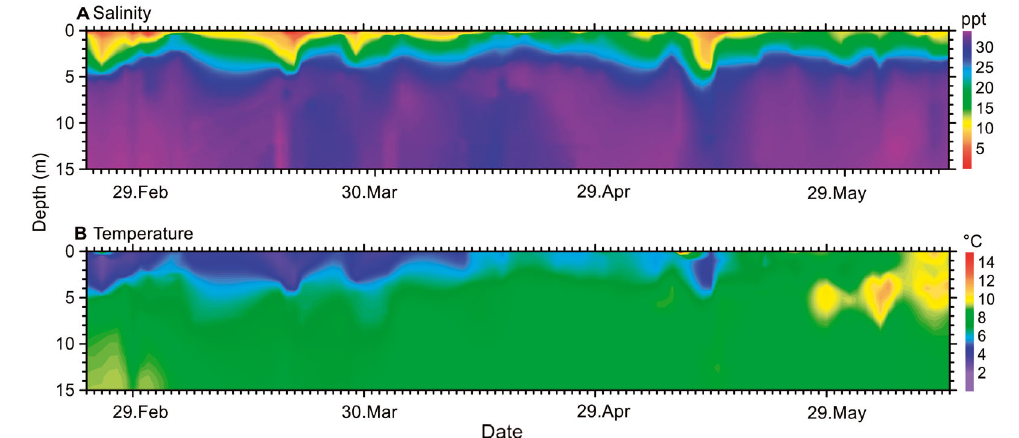
Fig. 5. (A) Salinity (ppt) and (B) temper- ature (°C) between 0 and 15 m depth dur- ing the